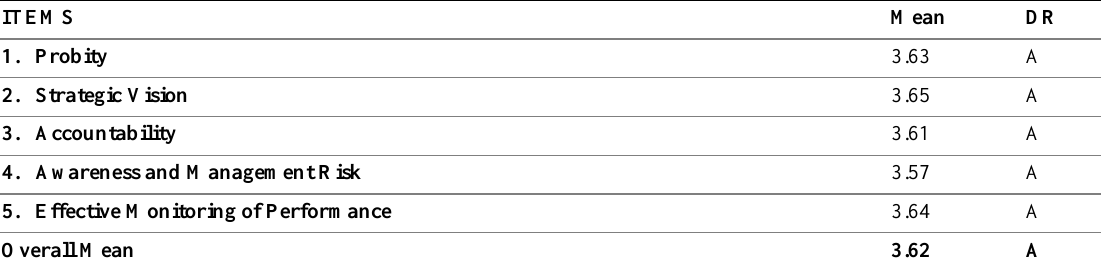
Table 6: Summary of Corporate